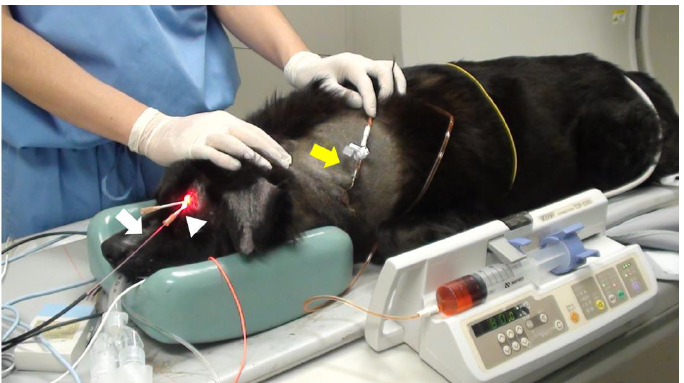
Figure 3. Interstitial photodynamic therapy and intra-arterial chemotherapy injection for case No. 10. A 12 year old, mixed-breed dog presented with swelling of the left frontal sinus. The dog was orally administered 40 mg/kg of 5-ALA. After 4 h, the tumor was interstitially irradiated with 630 nm laser light emitted (150 mW, 270 J) by a diode laser under general anesthesia. The dog also received weekly doses of 100 mg/m 2 carboplatin and 10 mg/m 2 doxorubicin. An over-the-needle intravenous catheter was inserted through the skin directly into the tumor under computed tomography imaging guidance. The cylindrical fiber (white arrow) could then be passed through an external cylinder of the catheter (white arrowhead). The fiber was placed inside a 14 gauge needle and inserted into the tissue. Doxorubicin hydrochloride was administered with a Huber needle through the skin into the port (yellow arrow). Cancers 2019 , 11 , x FOR PEER REVIEW